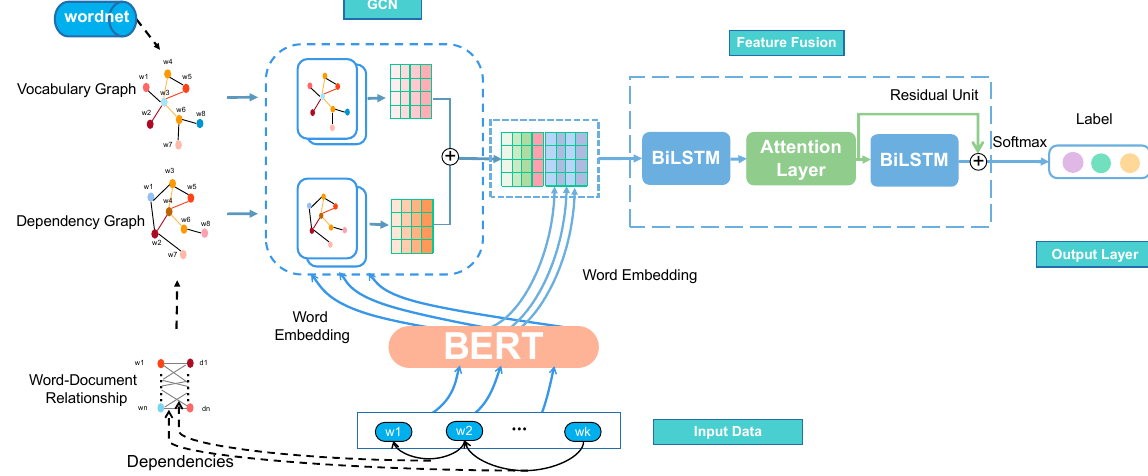
Figure 2. The architecture of IMGCN.